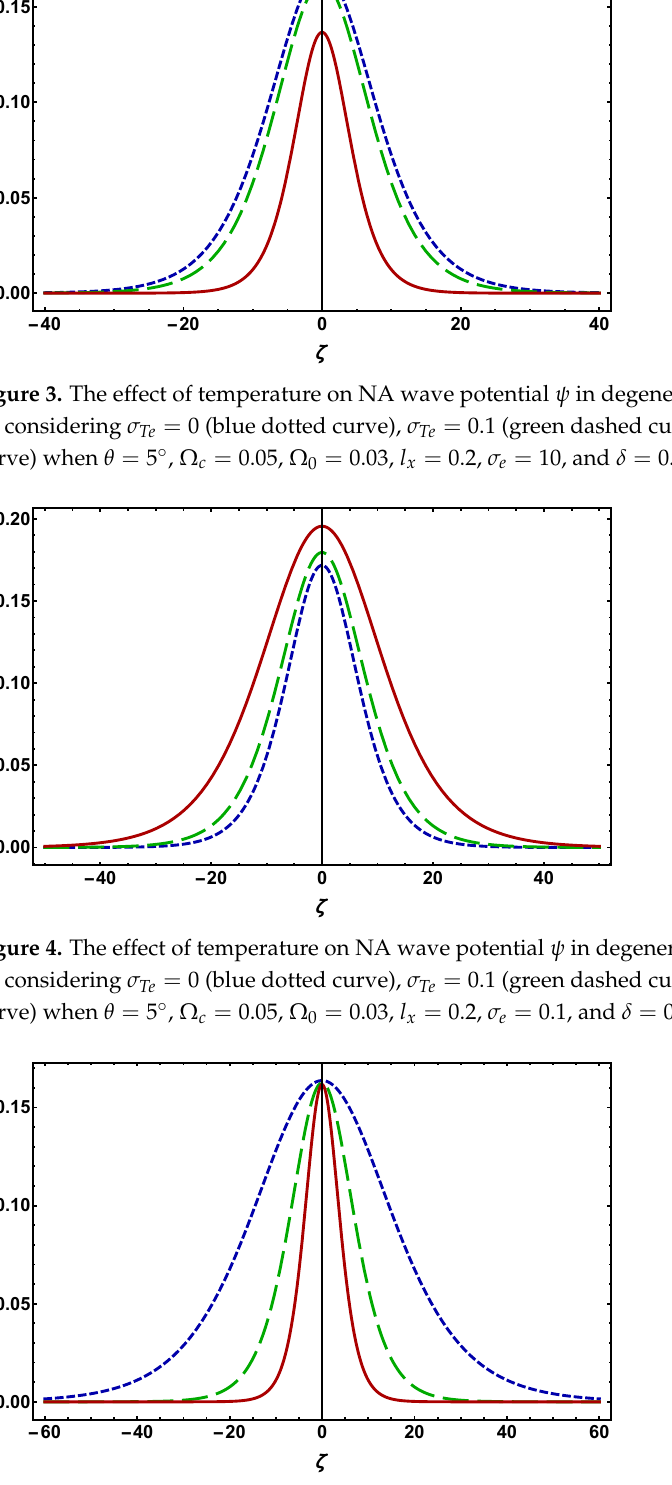
Figure 5. The effect of angular rotation of plasma system on NA wave potential ψ in degenerate non-relativistic plasmas by considering Ω 0 = 0 (blue dotted curve), Ω 0 = 0.03 (green dashed curve), and Ω 0 = 0.3 (red solid curve) when θ = 5 ◦ , Ω c = 0.05, l x = 0.2, σ e = 0.1, σ Te = 0.1, and δ =